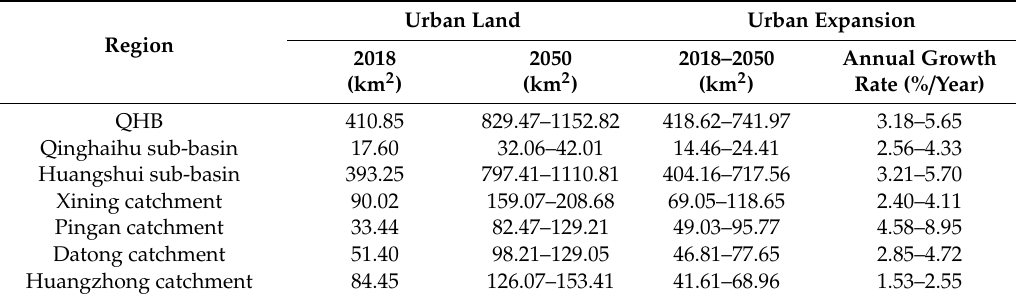
Figure 7. Urban expansion from 2018 to 2050. Table 6. Urban expansion from 2018 to